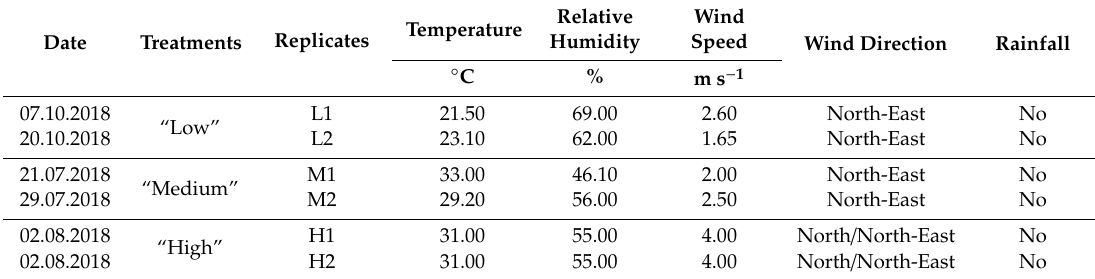
Table 1. Meteorological data used by the tool.